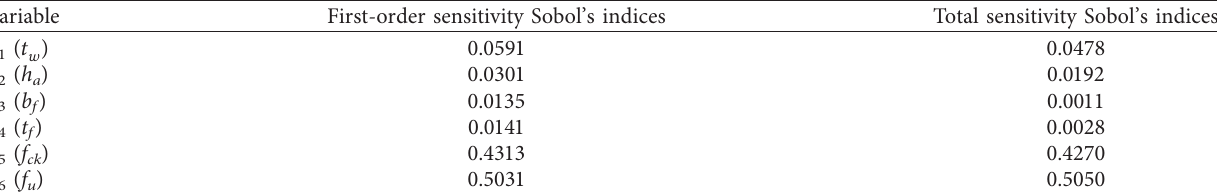
Figure 8: Convergence of the safe probability of the SCC beams at the design time ( t � 0). Table 7: Mean estimation with 200,000 Monte Carlo samples of first and total Sobol’s